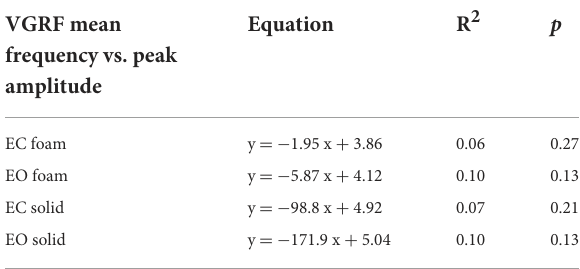
TABLE 1 Equations of the lines fitting the values of VGRF Mean frequency versus Peak amplitude in the four standing